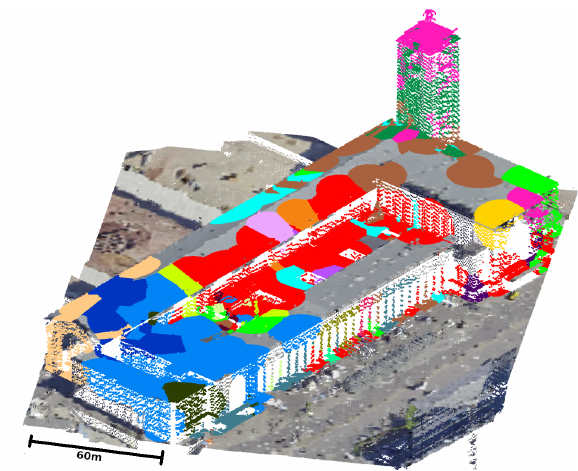
Figure 5. ALS point cloud colored with the resulting clusters on Building 1. Each color corresponds to a cluster (Fig. 6) and a time series in Figure 7.